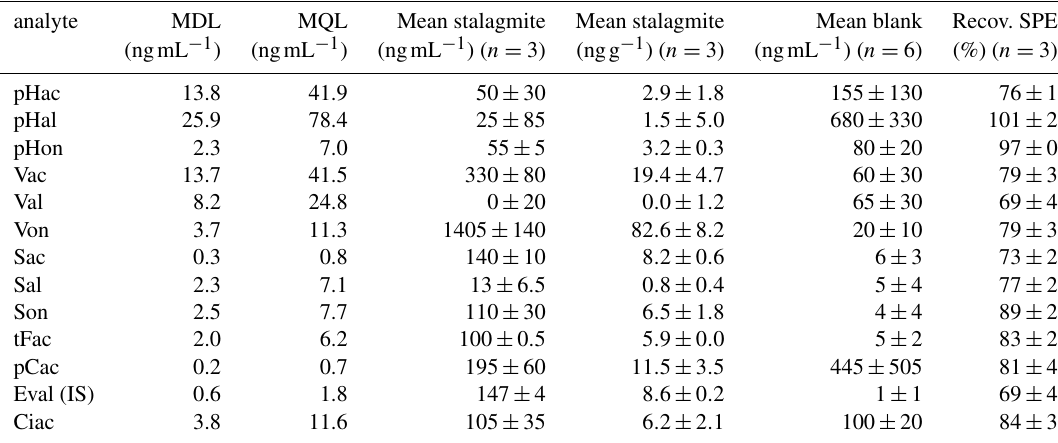
Table 2. Method detection limit after the subtraction of the reagent blank (MDL) in ngmL − 1 , method quantification limit after the subtraction of the reagent blank (MQL) in ngmL − 1 , mean value of three subsamples of 3.4g stalagmite after blank subtraction in ngmL − 1 and in ngg − 1 of the initial stalagmite sample, mean blank value of six reagent blanks measured on different days in ngmL − 1 , and recovery values of the SPE procedure to extract LOPs (Recov. SPE) in %. All concentrations in ngmL − 1 refer to the final sample solution injected into the LC–MS system. The errors stated in this table are standard deviations of n samples. For the methods of calculation used please refer to the text. The abbreviations for the analytes are shown in Table 1.